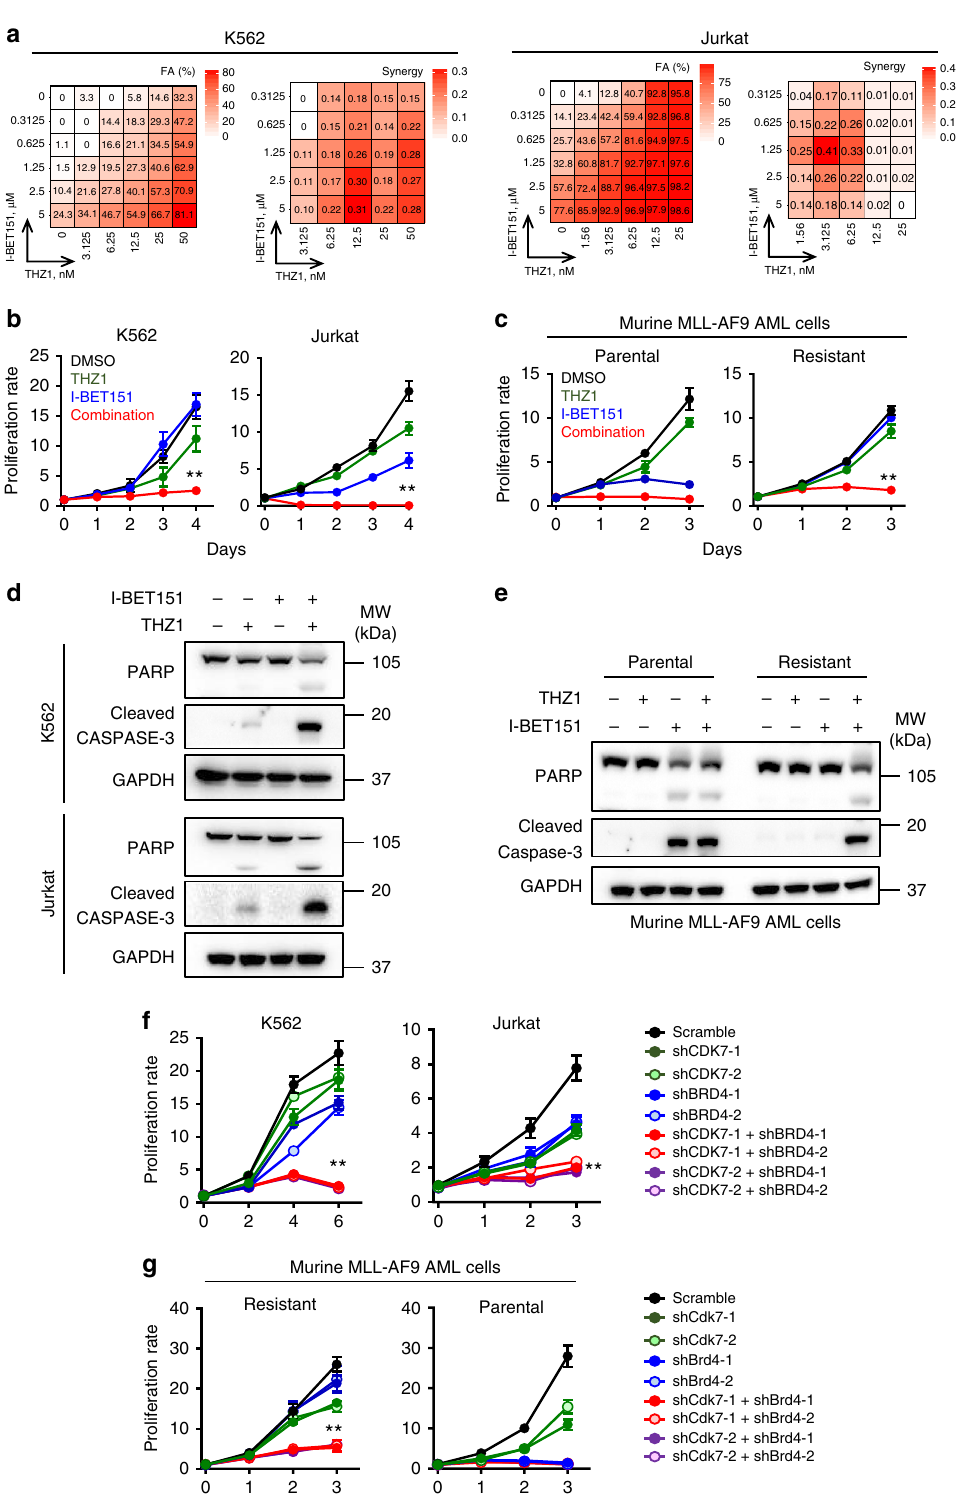
human leukemia cell lines (K562 and Jurkat, Fig. 2d and Supplementary Fig. 3d) and murine BETi-resistant AF9 AML cells (Fig. 2e and Supplementary Fig. 3e). Furthermore, we observed similar synthetic lethality by using other BET inhibitors, including JQ1, OTX-015, and I-BET762, in combination with THZ1 in BETi-resistant human and murine leukemia cells (Supplementary Fig.